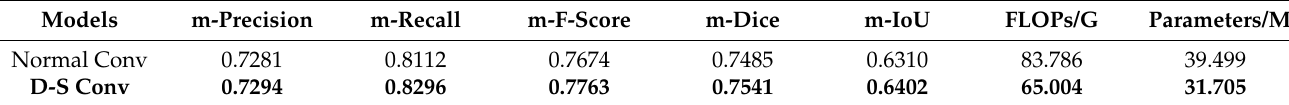
Table 5. Results of different convolution strategies. The best average scores are in bold.